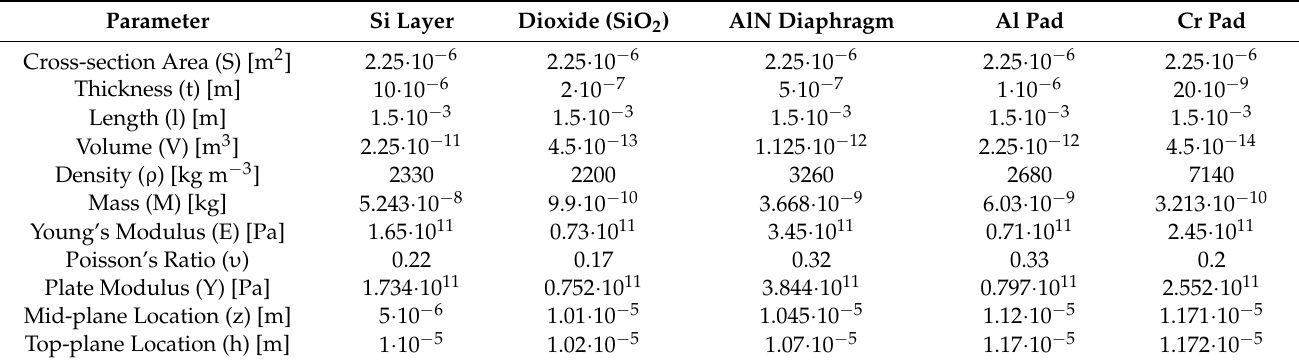
Table 2 shows the values of parameters of all layers constituting the pMUT. Table 2. Parameter values of all layers constituting the pMUT